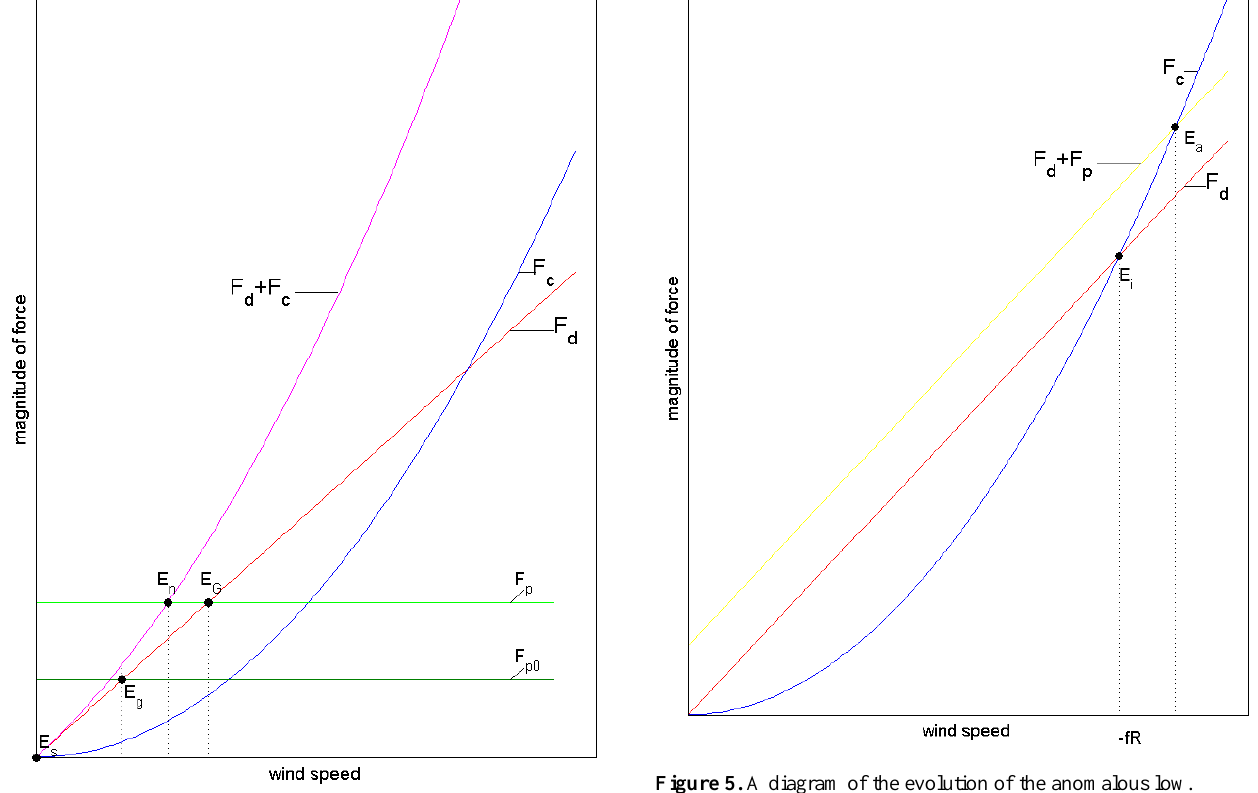
Figure 4. A diagram of the evolution of the normal low. F p repre- sents the pressure gradient forces and F p0 represents the pressure gradient force of the original geostrophic wind.